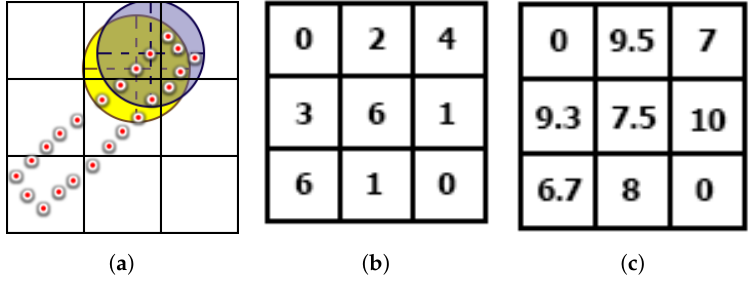
Figure 3. A 2D example illustrating the cell density calculation method. ( a ) Cells are represented as a 2D grid, where points in each cell are presented as red dots, and circles illustrate the neighborhood of two-point samples. ( b ) The classical method for computing density, where the density is simply the number of point in each grid. ( c ) The density calculated using the proposed method, where a neighborhood search is performed for each point to get a better density